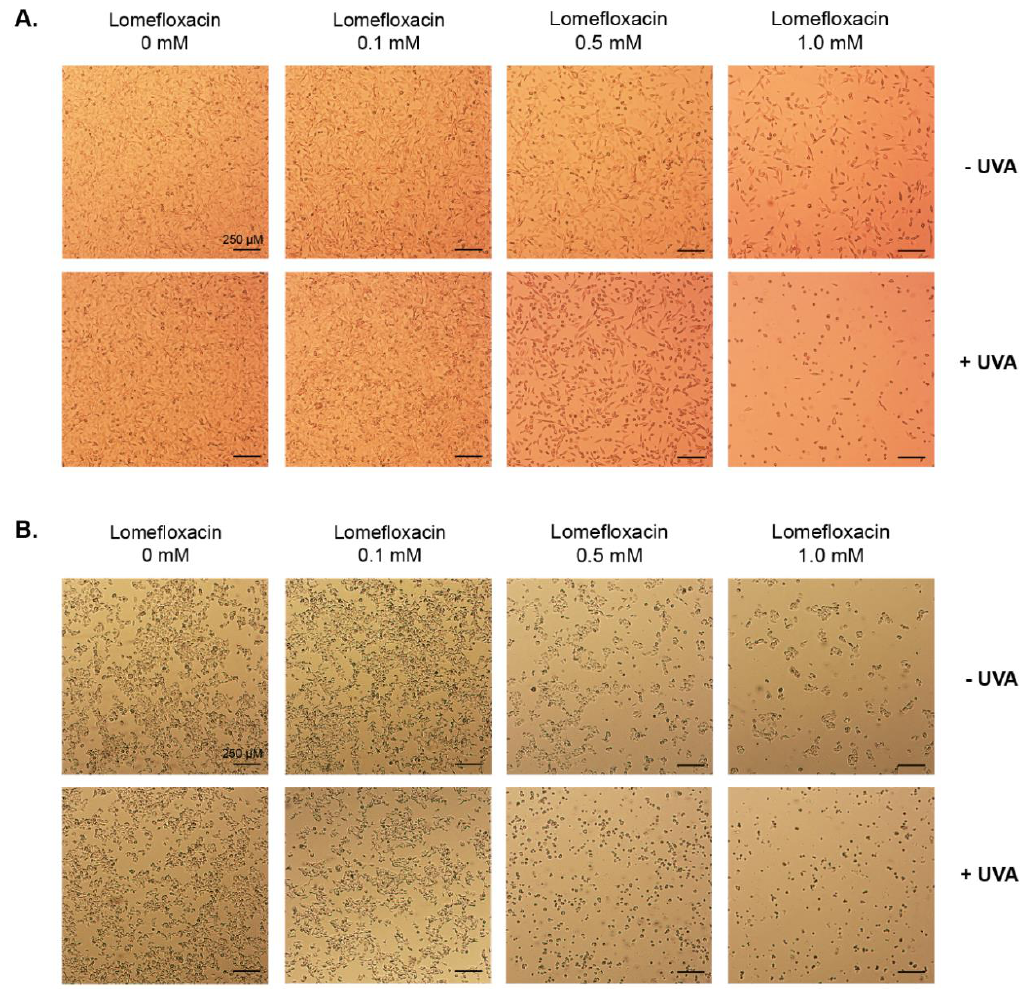
Figure 2. Combined treatment of C32 ( A ) and COLO829 ( B ) cells with lomefloxacin and UVA irradiation augments the induction of apoptotic features in melanoma cells. The cells were pre-treated with lomefloxacin at concentrations of 0.1, 0.5, and 1.0 mM alone for 24 h or exposed to the drug and UVA irradiation (1.3 J/cm 2 ) and observed under a light inverted microscope at a 40x magnification (scale bar 250 µm).